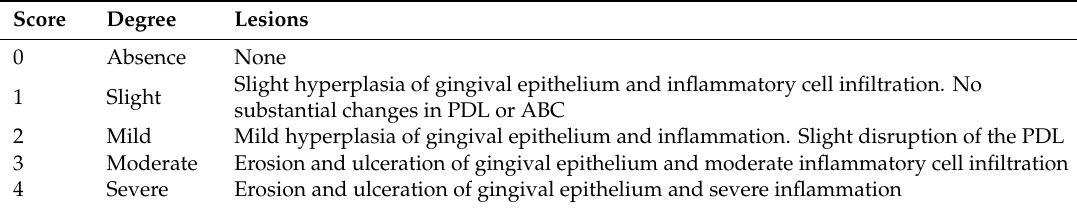
Table 2. Inflammation assessment criteria for periodontal status.